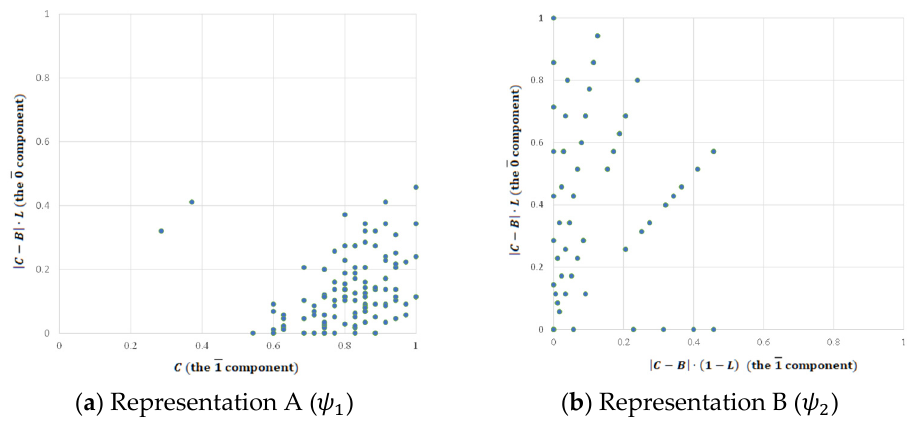
Figure 6. Graphical representations of the soft numbers yielded by the empirical study.